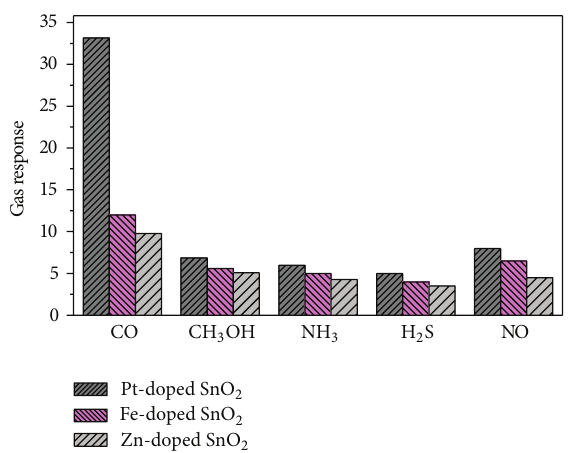
Figure 5: Gas responses of the sensors to different CO concentra- tions.